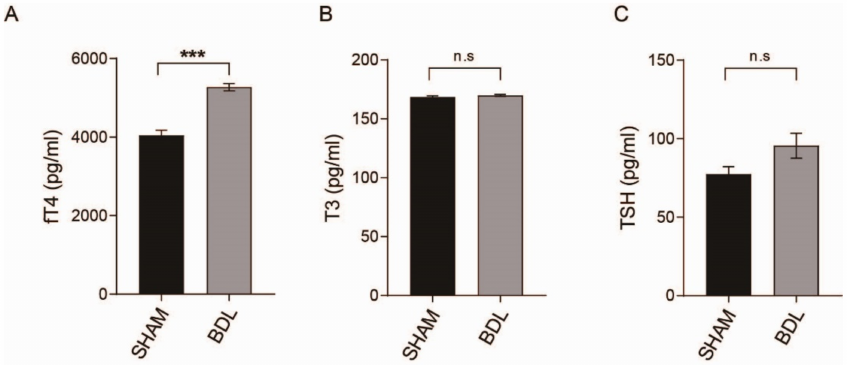
Figure 5. ELISA data. ( A ) ELISA to detect free T4, ( B ) T3, and ( C ) TSH in blood serum of sham and BDL mice. p -value *** is <0.001 and n.s means no